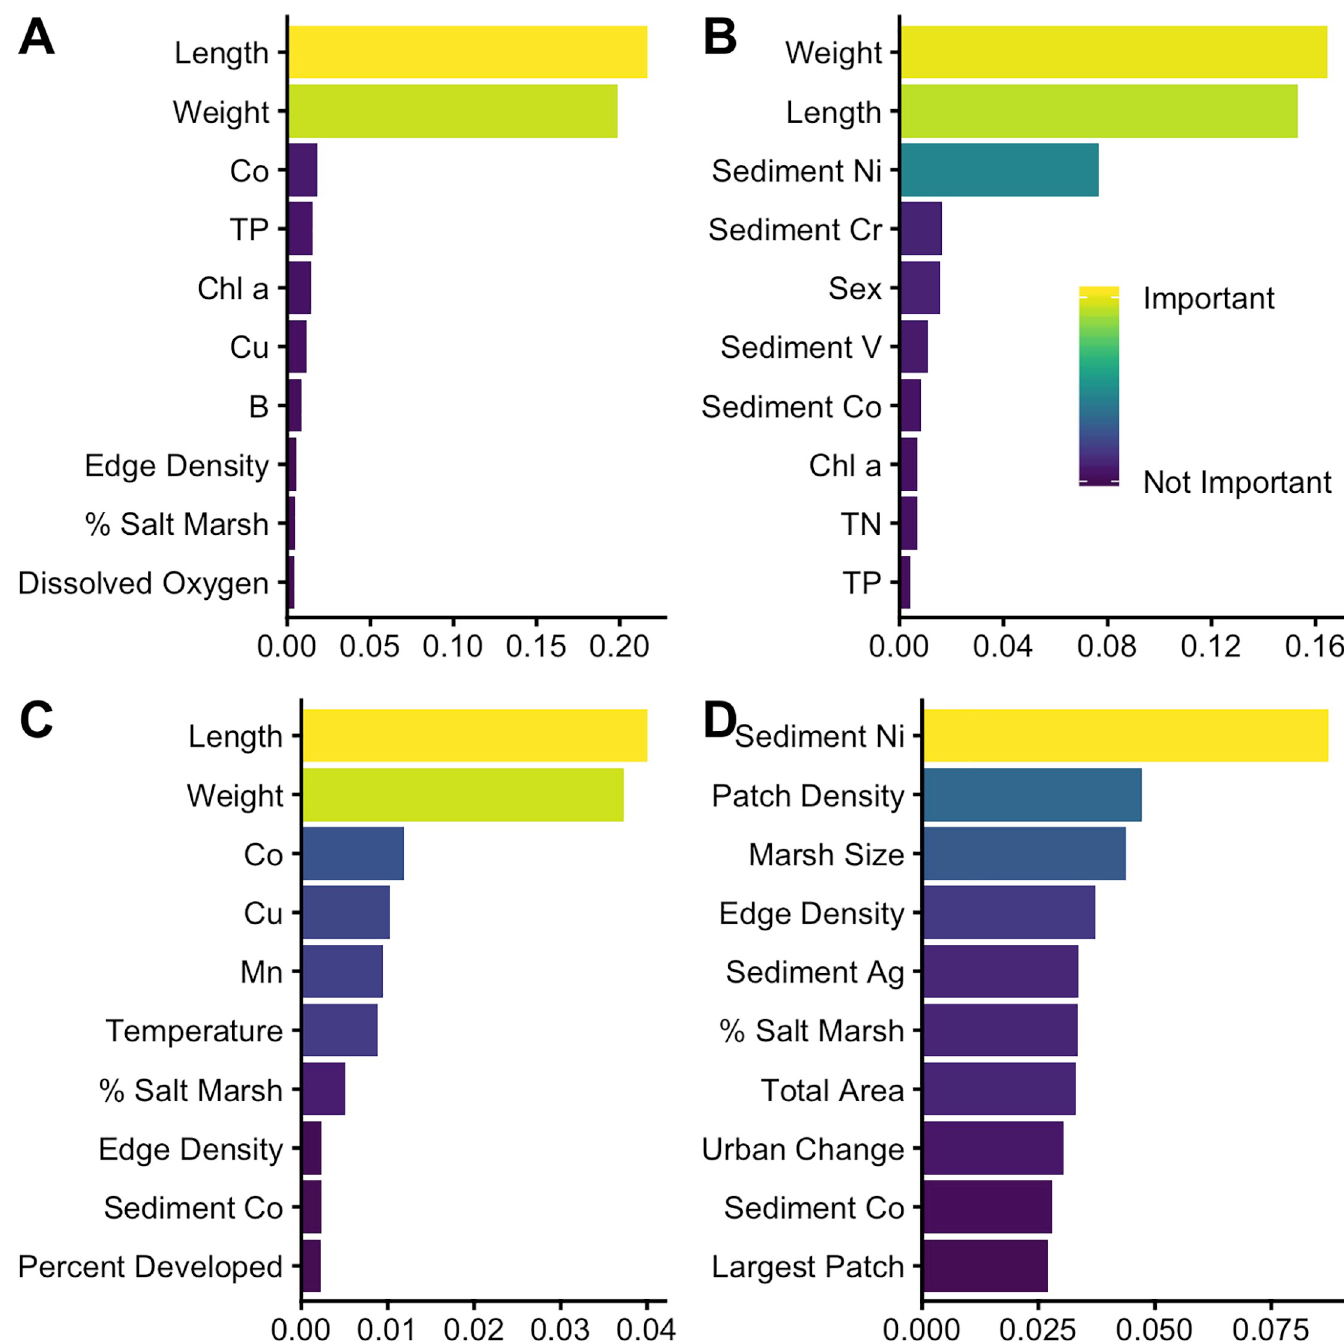
Fig 3. Multivariate random forest model standardized variable importance. Variable importance in the model predicting: direct life-cycle parasite community structure at the infracommunity scale (A); indirect life-cycle parasite community structure at the infracommunity scale (B); direct life-cycle parasite community structure at the component community scale (C); and indirect life-cycle parasite community structure at the component community scale (D).